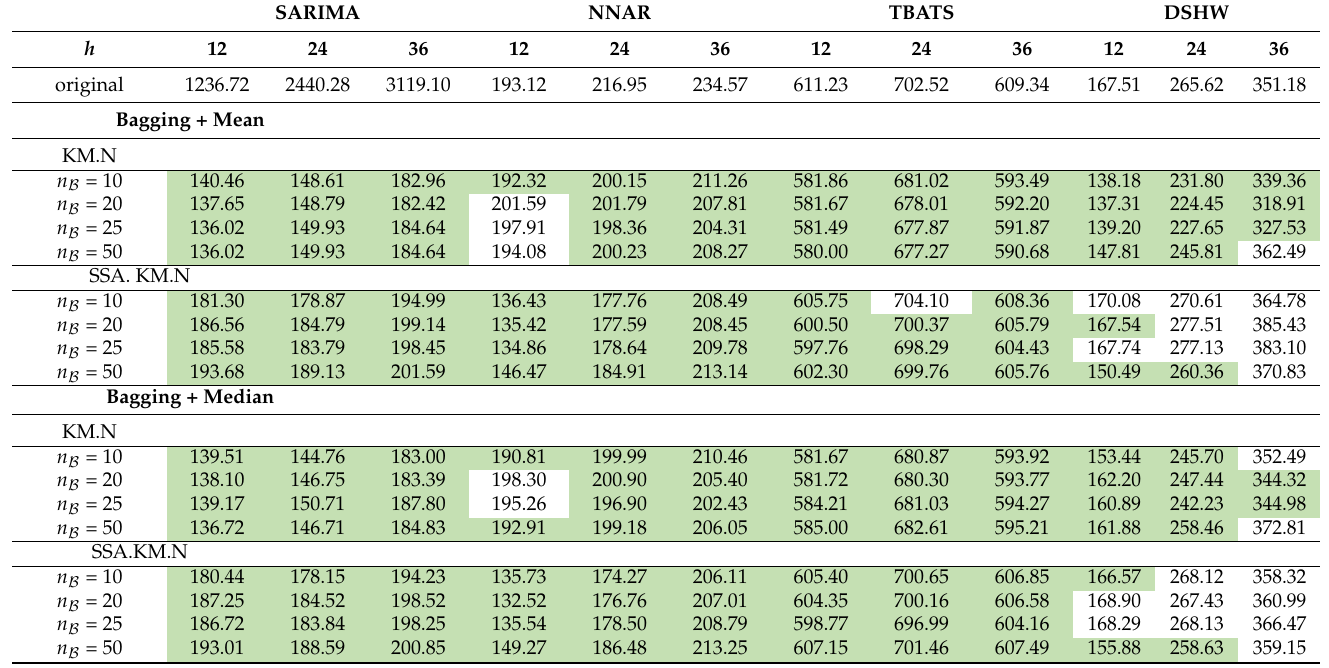
Figure 6. The hourly electricity load of Indonesia between 1 October and 30 November 2015. Table 12. RMSE of h -step ahead forecast for the hourly electricity load of Indonesia obtained by SARIMA, NNAR, TBATS, and DSHW models. SARIMA NNAR TBATS